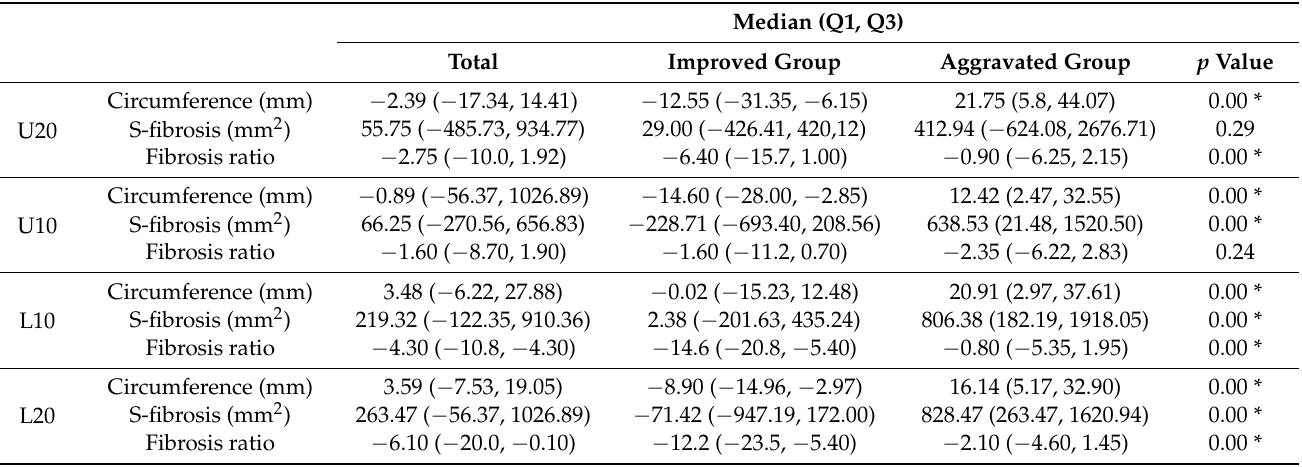
Figure 1. Bidirectional change of subcutaneous fibrosis in computed tomography (CT) scan. Fibrosis was improved in follow-up ( B ) than initial ( A ). Fibrosis was aggravated in follow-up ( D ) than initial ( C ). Table 3. The difference of circumference, fibrosis, and ratio of fibrosis between the initial and follow-up CT in two study groups.